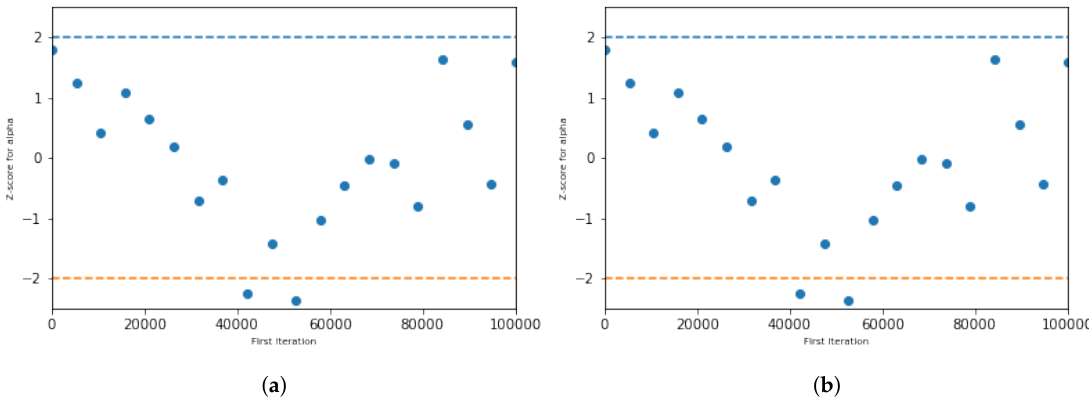
Figure 4. Convergence of values for GR and Delta Gravity. ( a ) Evolution of z -scores with steps in GR. ( b ) Evolution of z -scores with steps in Delta